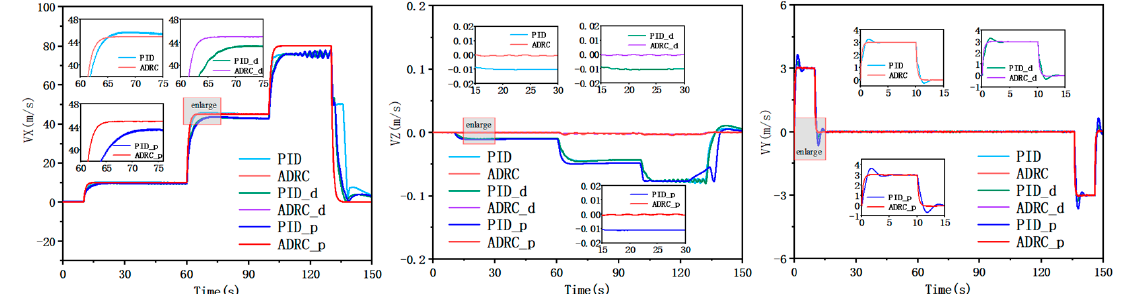
Figure 12. Three-axis velocity response in body axis.